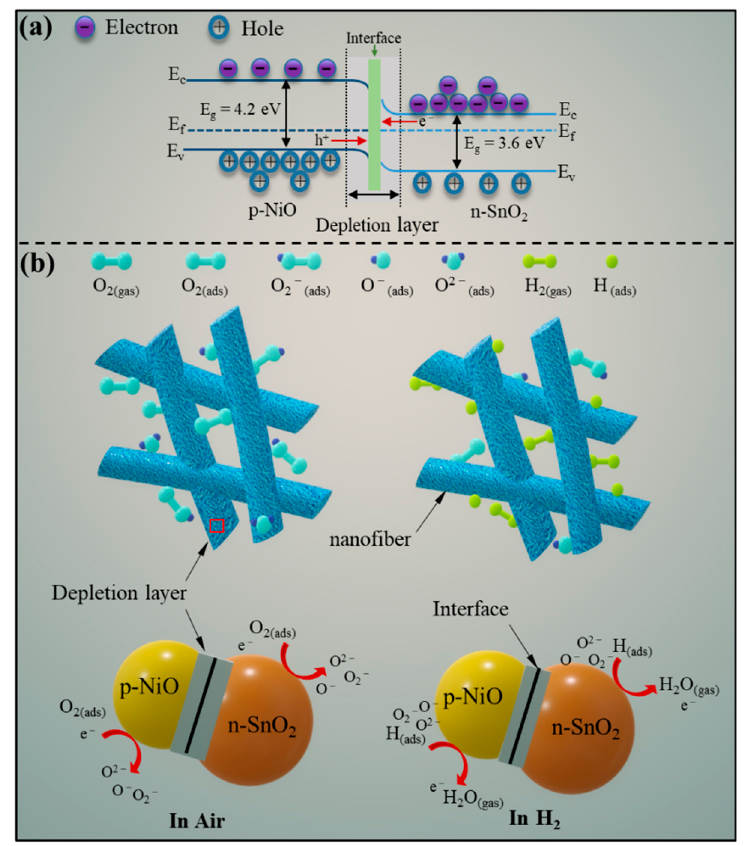
Figure 10. Schematic diagrams of ( a ) the energy band for p-n heterojunctions of NiO / SnO 2 and ( b ) the proposed H 2 sensing mechanism for the NiO / SnO 2 nanocomposite.